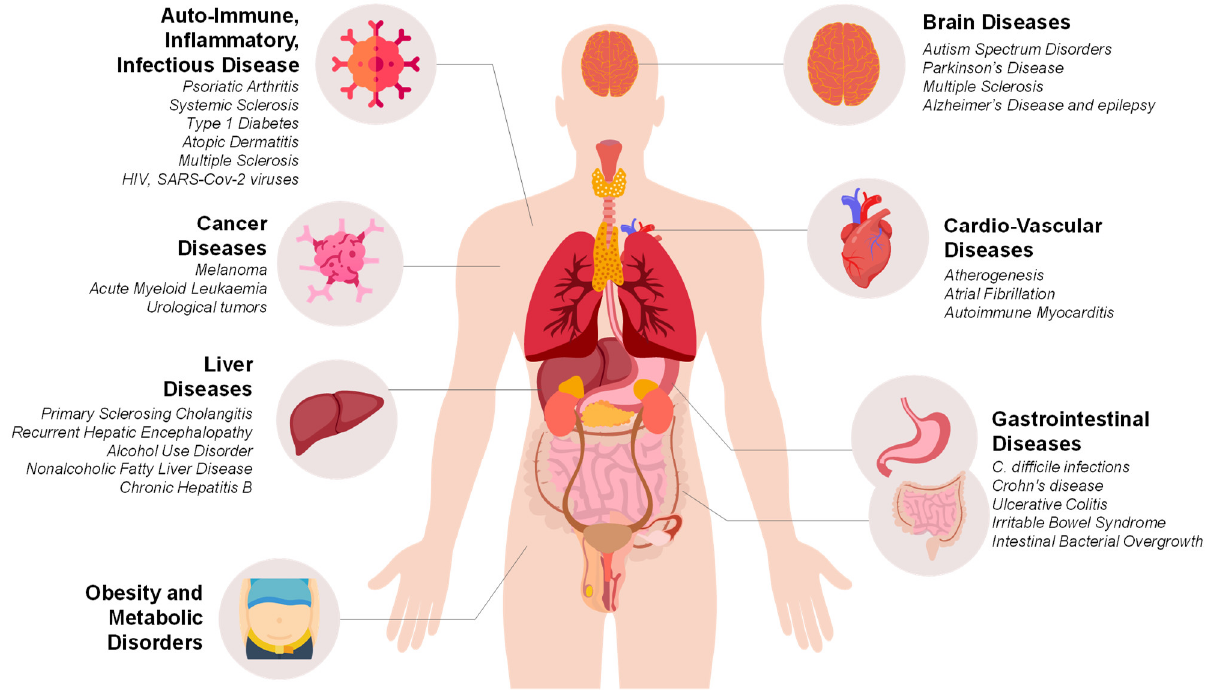
Figure 3. Fecal microbiota transplantation in human diseases. Schematic cartoon summarizing fecal microbiota transplantation-based clinical trials in the different human diseases. Refer to the text for details.